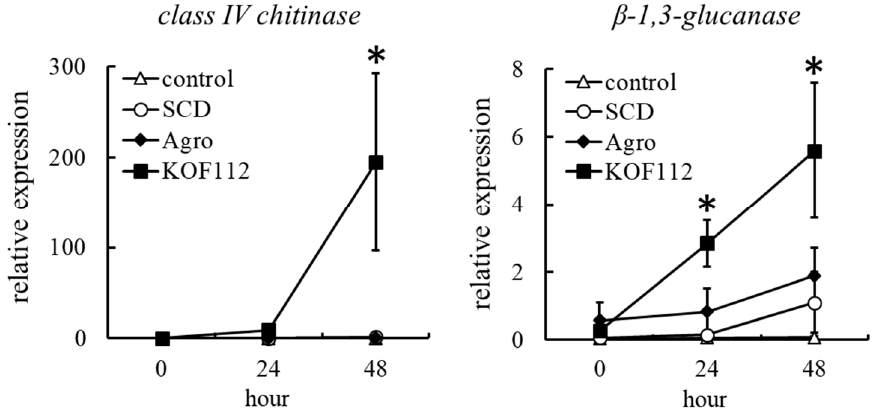
Figure 9. Transcription profiles of genes encoding class IV chitinase and β -1,3-glucanase in grape leaves treated with KOF112. Transcription levels of the genes in grape leaf disks 0, 24, and 48 h after KOF112 treatment were estimated by real-time RT-PCR. Data were calculated as gene expression relative to ubiquitin gene expression. Bars indicate means ± standard deviations of three independent experiments with three leaf disks. * p < 0.05 compared with control and SCD. Control, untreated. SCD, treated with 10% SCD. KOF112, treated with 1 × 10 8 cfu/mL KOF112. Agro , treated with 1 × 10 8 cfu/mL Agrobacterium sp. isolate CHB3, used as a control isolate with no antifungal activity.